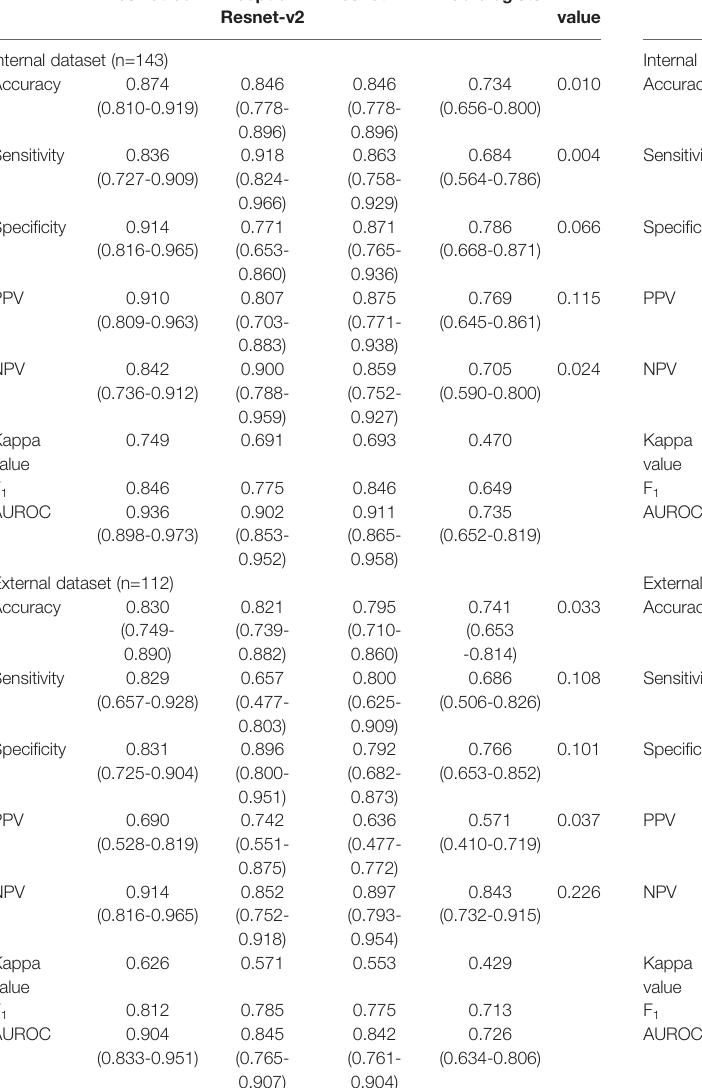
TABLE 4 | Performance of deep learning containing three CNNs compared with the radiologists in differentiating benign and malignant thyroid nodules classi fi ed into ACR TI-RADS category